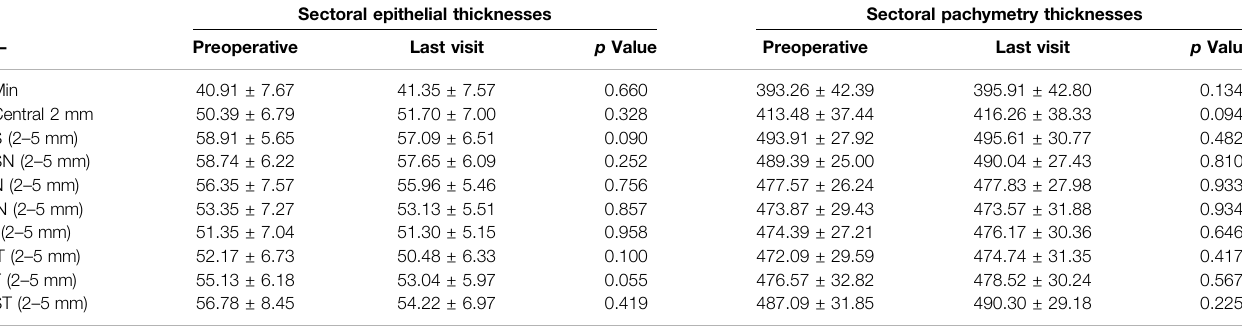
TABLE 2 | Sectoral epithelial and pachymetry thicknesses ( μ m) (Mean ± SD). Sectoral epithelial thicknesses